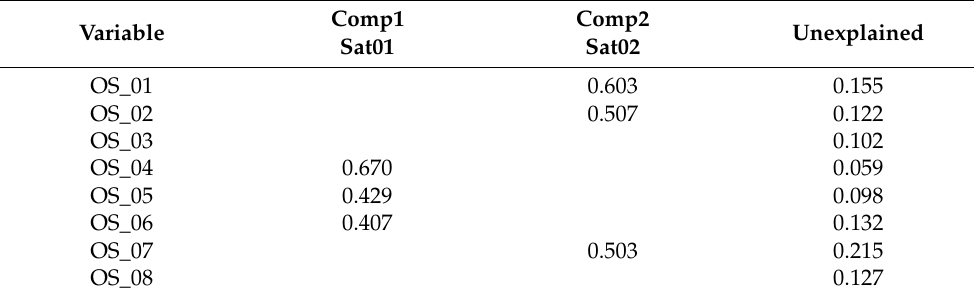
Table 18. Rotated component matrix—overall